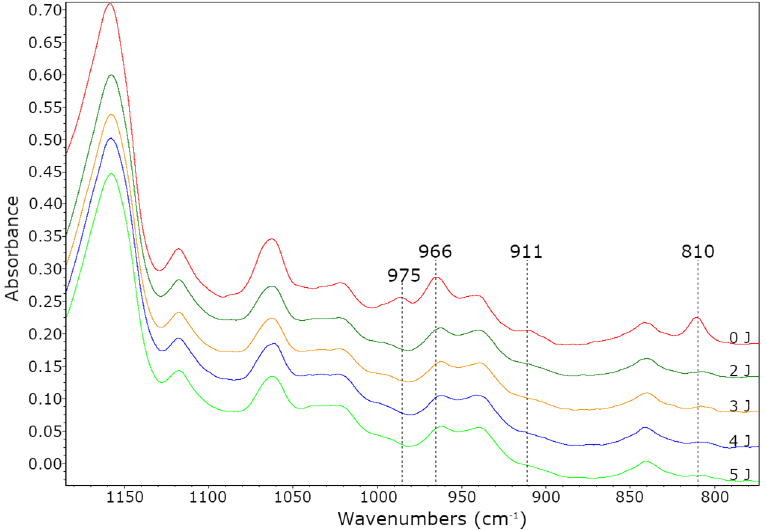
Figure 8. FTIR spectra of PSA-7.5 after the UV crosslinking process.